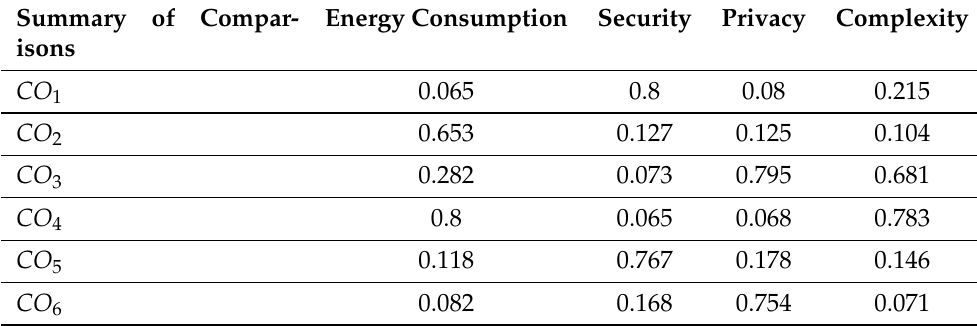
Table 16. Summarized relative weight matrix of the alternatives